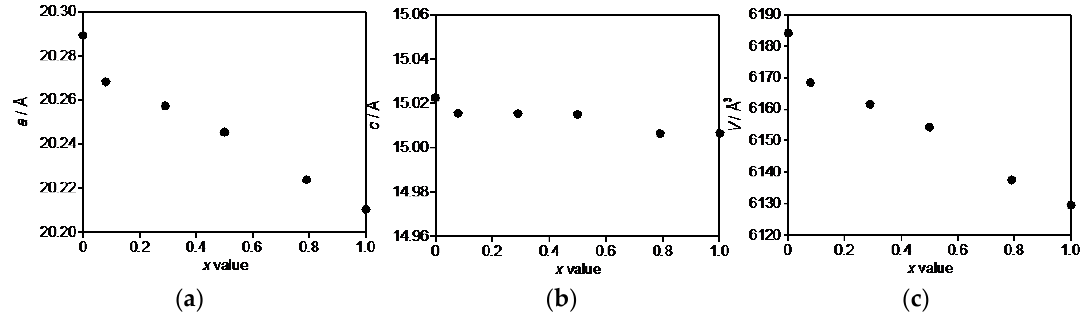
Figure 2. x dependence of ( a ) the a -axis; ( b ) the c-axis; and, ( c ) the unit cell volume ( V ).